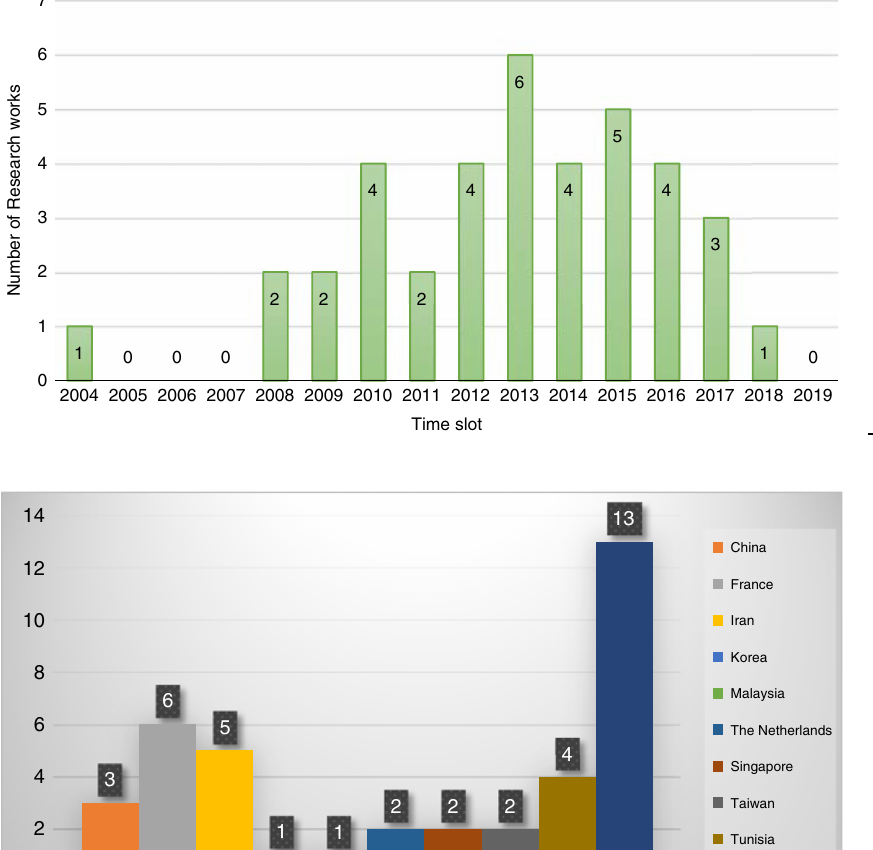
Figure 2. Countries of published